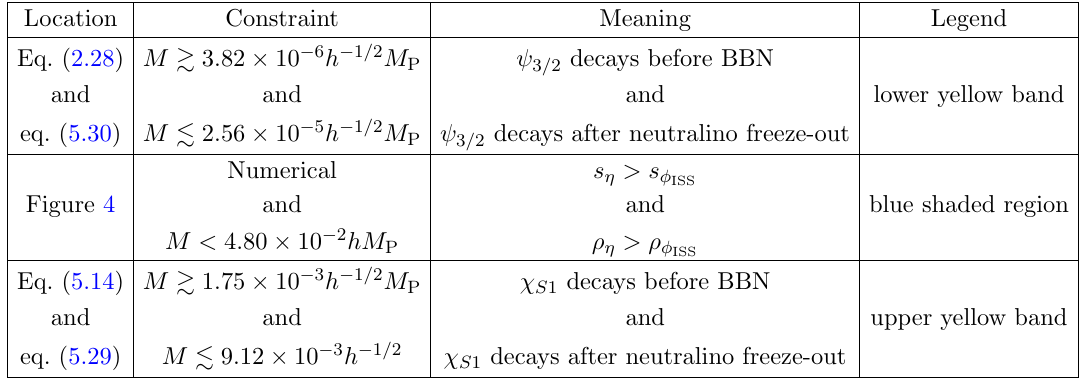
Table 5 . All constraints on the ISS parameters M and h we take into account in this section. Their location in the text, their meaning, and their depiction in the (cid:12)gures of this section are also given. Here we allow for the extension of the blue shaded region for the plots of (cid:31) S 1 when the entropy production from gravitinos should not be considered, which has already been mentioned earlier in (cid:12)gure 4 of section